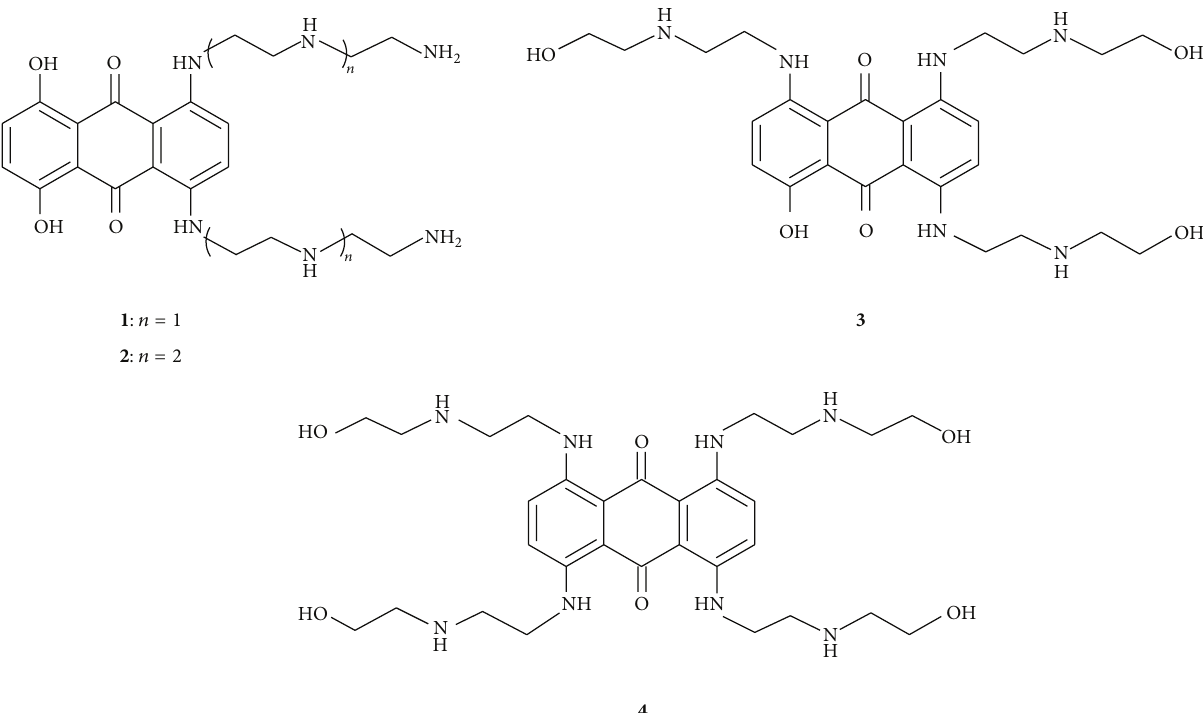
Figure 3: MTX analogs that retain or enhance the ability to bind and stabilize the tau RNA stem-loop